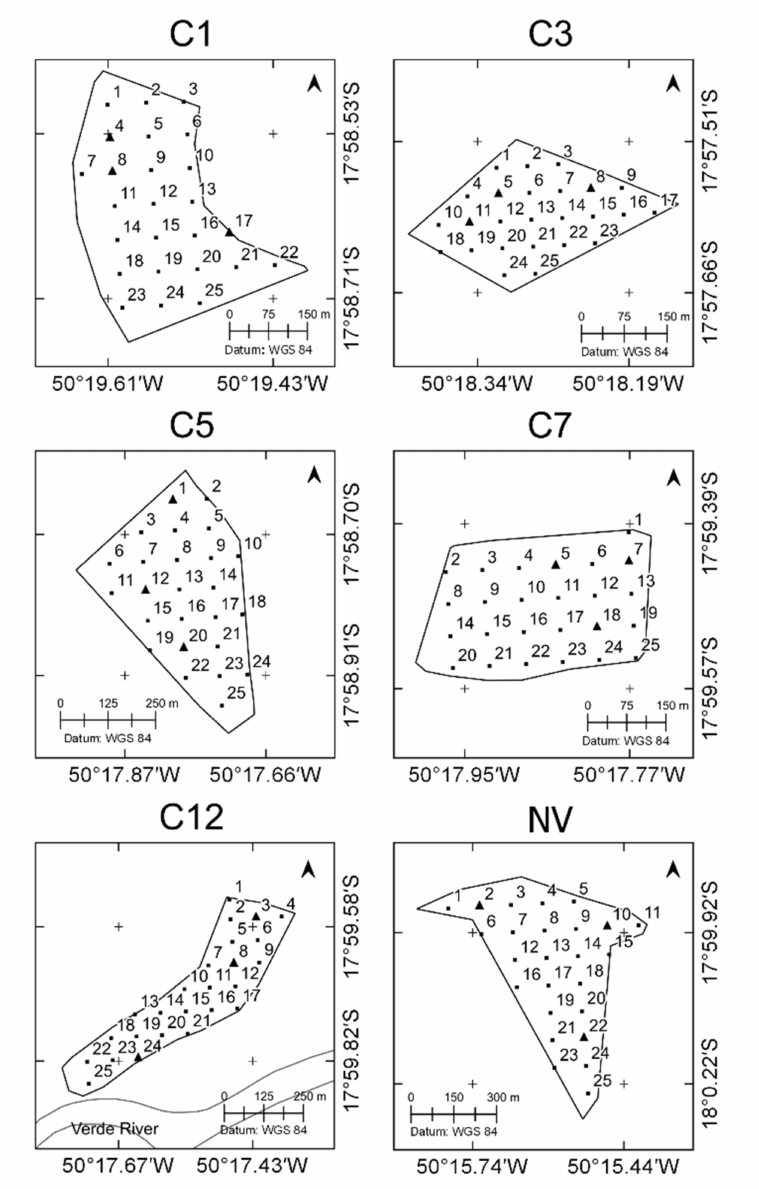
Figure 2. Soil sampling grid on the plots in the study area in the midwest region of Brazil. C1: sugarcane with one year of cultivation; C3: three years of cultivation; C5: five years of cultivation; C7: seven years of cultivation; C12: twelve years of cultivation; and NV: native vegetation. The undisturbed samples in stainless steel cylinders were prepared in the laboratory by removing excess soil and saturating them by capillarity by filling with water to 2/3 of the height of the cylinders and weighing them. After this procedure, the samples were subjected to matric potentials of − 1, − 3, and − 6 kPa on a tension table and − 10, − 33, − 80, − 400, − 1000, and − 1500 kPa in a Richards extractor, and the respective weights were recorded after drainage had stopped or had become negligible. Lastly, the samples were dried in an oven at 105 ◦ C for 48 h and weighed again Teixeira et al. [50]. The calculations of soil density (Bd), total porosity (Tp), macroporosity (Ma), and microp- orosity (Mi) were determined according to the procedures described by Donagema et al. [51] and Santos at al. [52]. The attribute blocked pores (Bp) was calculated according to the method described by Libardi [53] and the soil aeration capacity (SAC) using the equation of Reynolds et al.